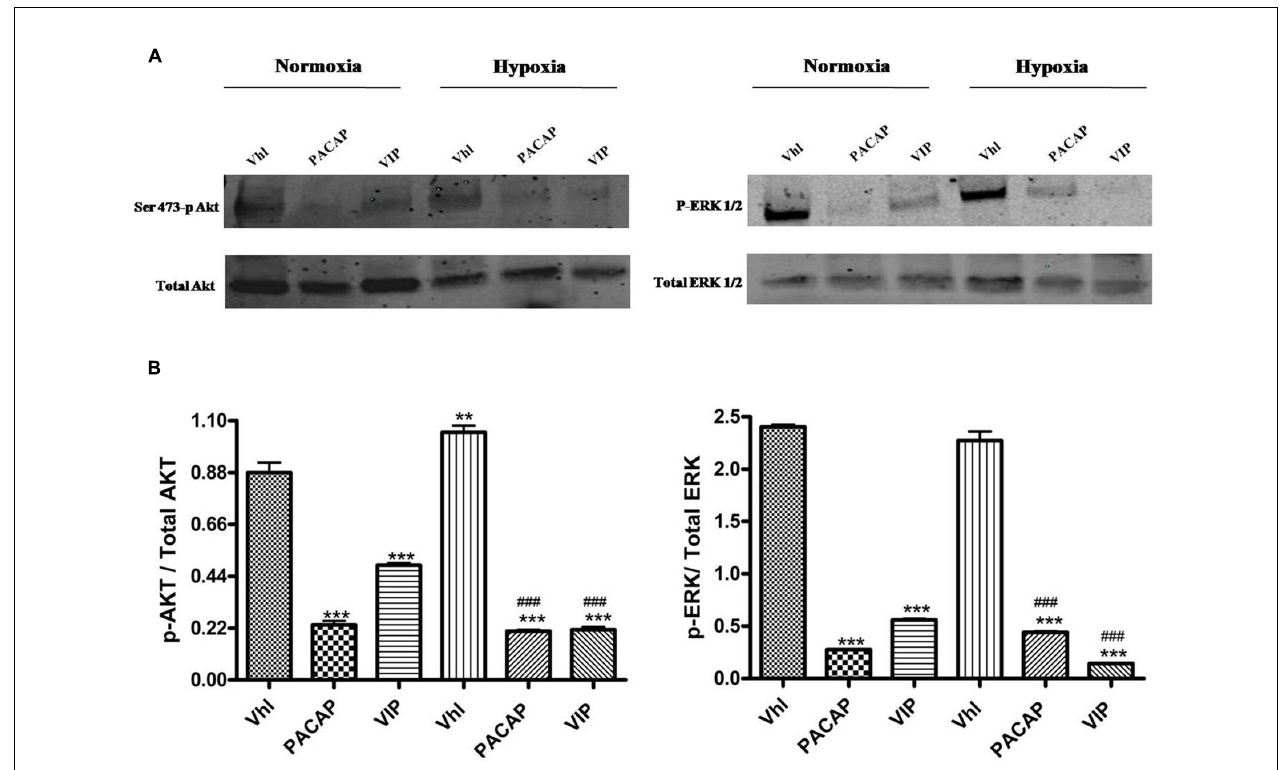
FIGURE 6 | Phosphorylation of AKT and ERK1/2 in U87-MG cells under normoxia and hypoxia. (A) Representative immunoblots of Ser473-p Akt or p-Erk1/2 expression on U87MG cells treated with PACAP or VIP under normoxia or hypoxia. (B) The bar graphs show quantitative analysis of signals obtained by immunoblots resulting from three independent experiments. Relative band densities were quantified by using ImageJ software. Each signal of phosphorylated protein was normalized to total protein expression. Data are expressed as mean ± SEM ( ∗∗ p < 0.01, ∗∗∗ p < 0.001 vs. Vhl under normoxia; ### p < 0.001 vs. Vhl under hypoxia as determined by one-way ANOVA followed by the Tukey post hoc